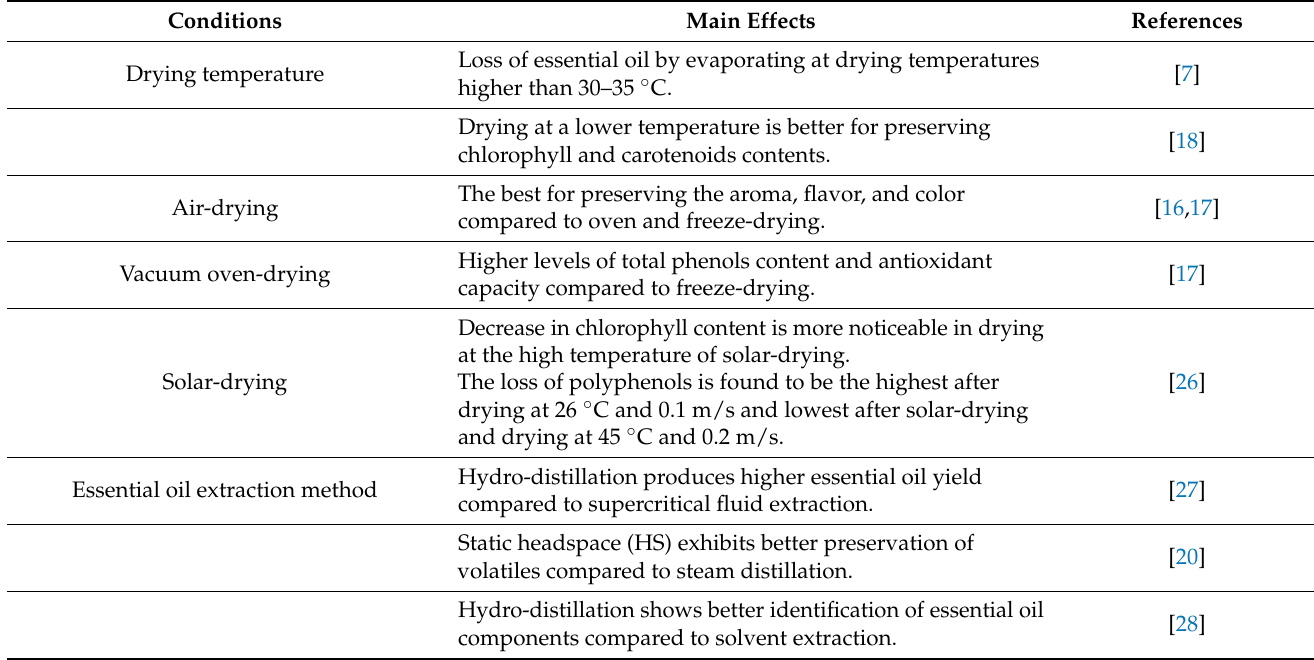
Table 4. Effect of post-harvesting conditions of Origanum syriacum